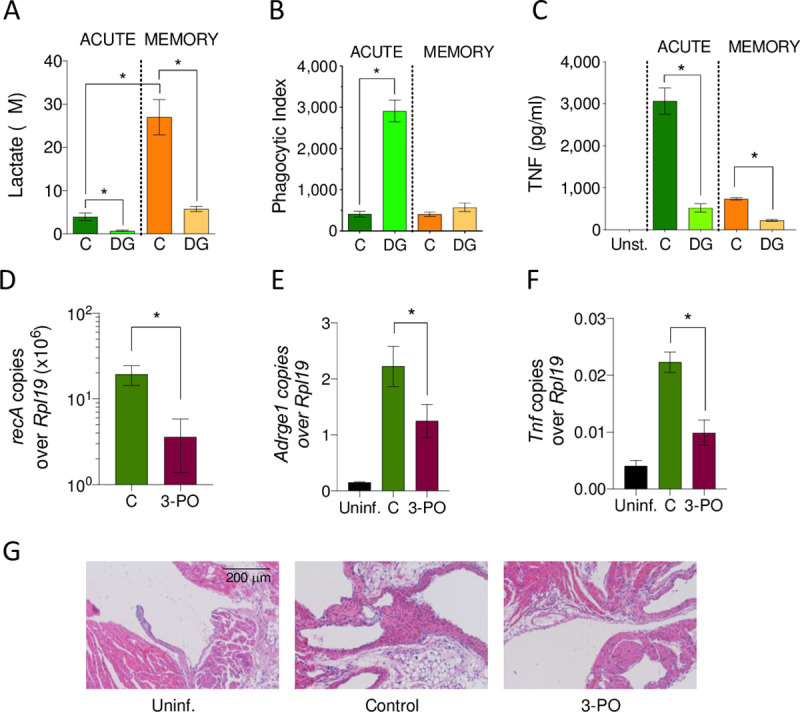
Glycolysis inhibition regulates the response of murine macrophages and modulates inflammation during infection.(A) Lactate production, (B) phagocytosis, and (C) TNF induction by B. burgdorferi in acute and memory macrophages in the presence or absence of the glycolysis inhibitor, 2-DG. (D) B. burgdorferi burdens in the heart of 3-PO-treated, infected mice (purple bar) compared to control-treated animals (green bar), as determined by DNA real-time PCR using primers specific for recA and relative to the housekeeping gene, Rpl19. (E) Macrophage infiltration and (F) Tnf gene expression in the heart of 3-PO-treated, infected mice (purple bars), control-treated infected animals (green bars) and uninfected controls (black bars) as determined by cDNA real-time PCR relative to Rpl19. The mice were infected for 2 weeks and then treated with the inhibitor for 3 more weeks. The results shown represent 5 mice per group. *, p < 0.05. (G) Hematoxylin and eosin staining of representative heart sections from mice infected with B. burgdorferi and treated with the glycolysis inhibitor, 3-PO. The data underlying the graphs in Fig 6 can be found in S6 Data. 2-DG, 2-deoxyglucose; 3-PO, 3-(3-pyridinyl)-1-(4-pyridinyl)-2-propen-1-one; PCR, polymerase chain reaction; TNF, tumor necrosis factor; Uninf.,uninfected.